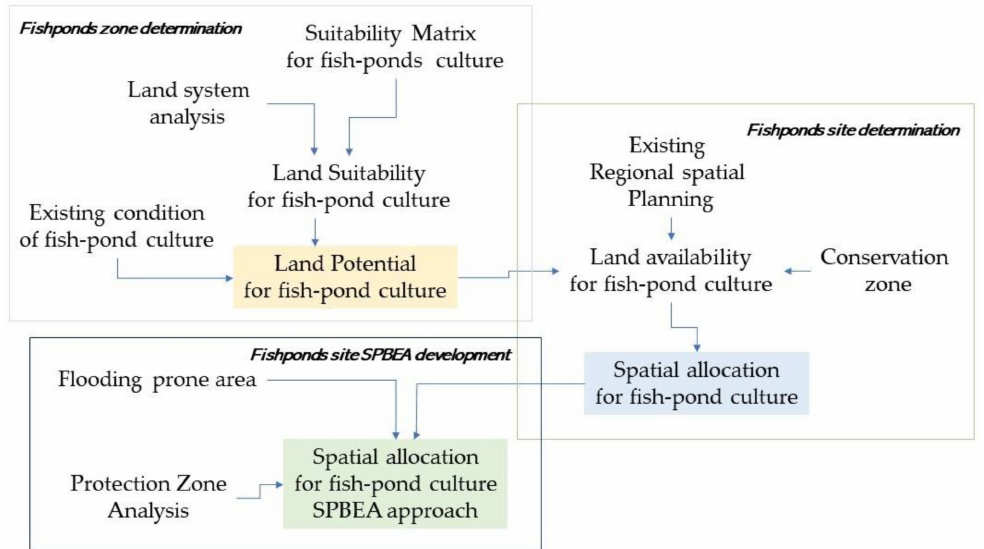
Figure 3. The steps of spatial-planning-based ecosystem adaptation (SPBEA) model